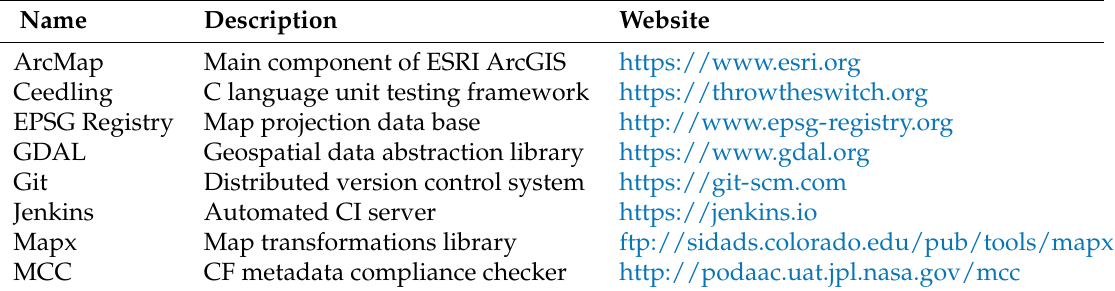
Table 3. Referenced software packages used during ESDR system